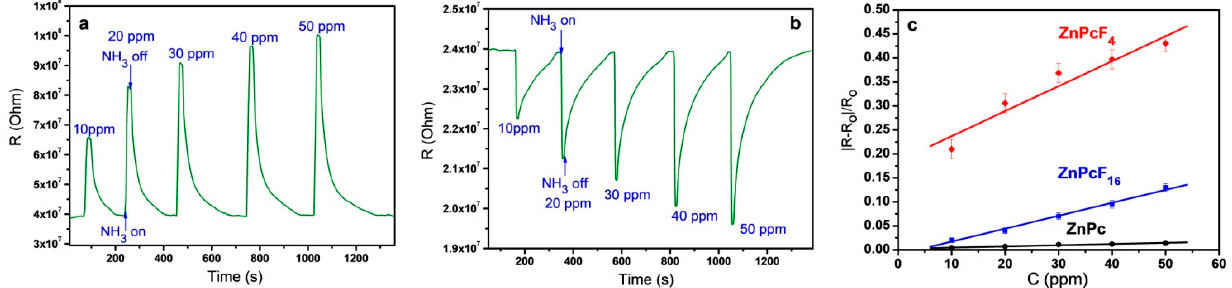
Figure 4. Sensor response of CoPcF 4 ( a ) and CoPcF 16 films ( b ) to ammonia. Dependence of the sensor response of ZnPcF x (x = 0, 4, 16) films on ammonia concentration ( c ) [21].